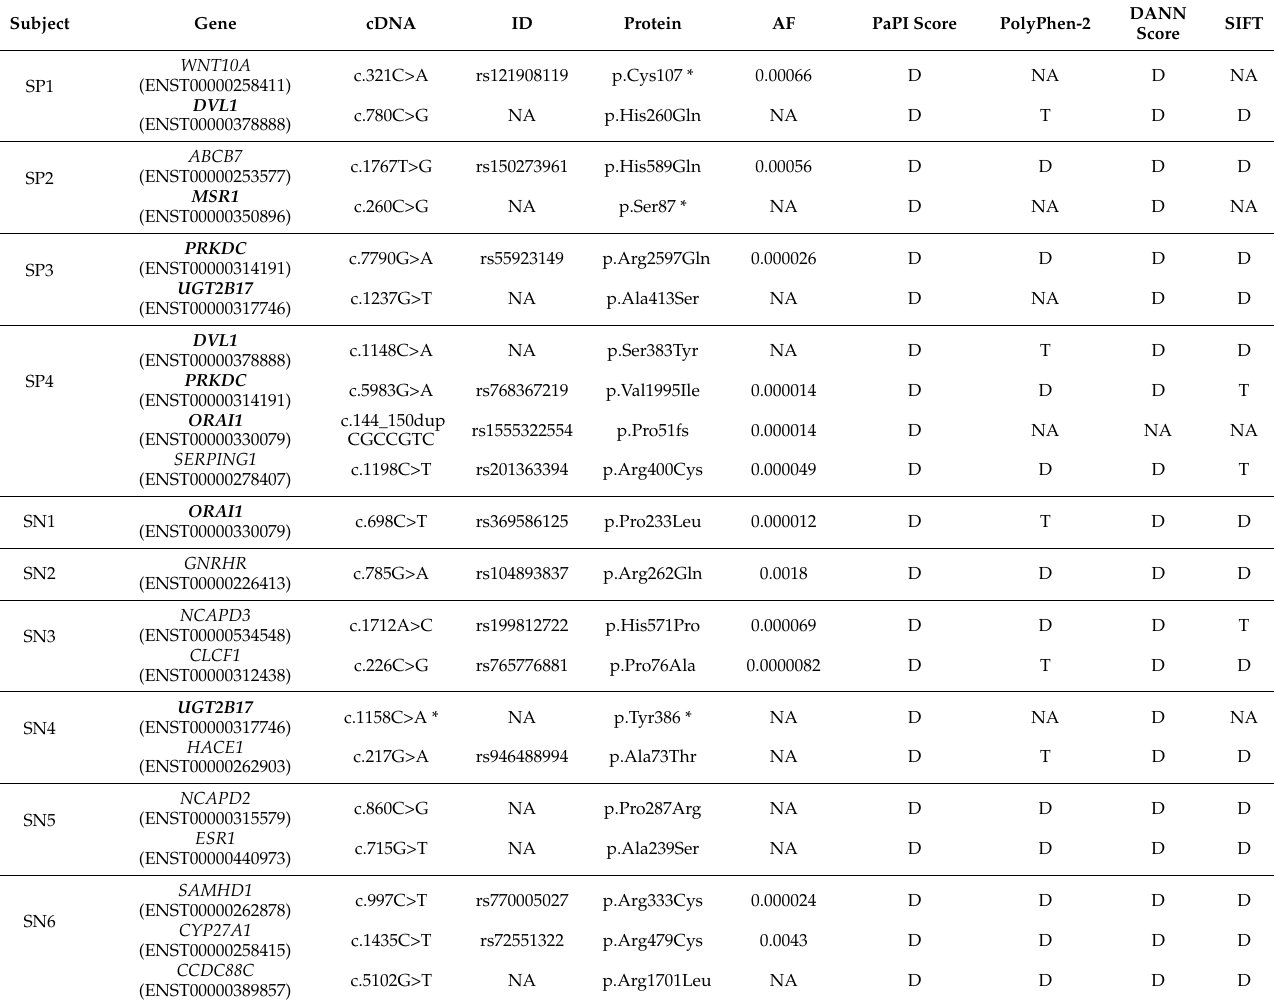
Table 4. Variants identified the RA/PsA cohort through WES. The table displays the variants detected in the patients. All variants were detected at the heterozygous state, except the one detected within the UGT2B17 gene in patient SN4 (c.1158C>A, p.Tyr386*), which is indicated in the table with the asterisk. Genes reported in bold are those in which a variant was found in more than one patient. The MSR1 gene is also reported in bold because, in addition to the frameshift variant carried by subject SP2, a large deletion affecting the gene was identified in patient SN3 through the SNPs-array technique. (AF = allele frequency; NA = not available; D = damaging; T =